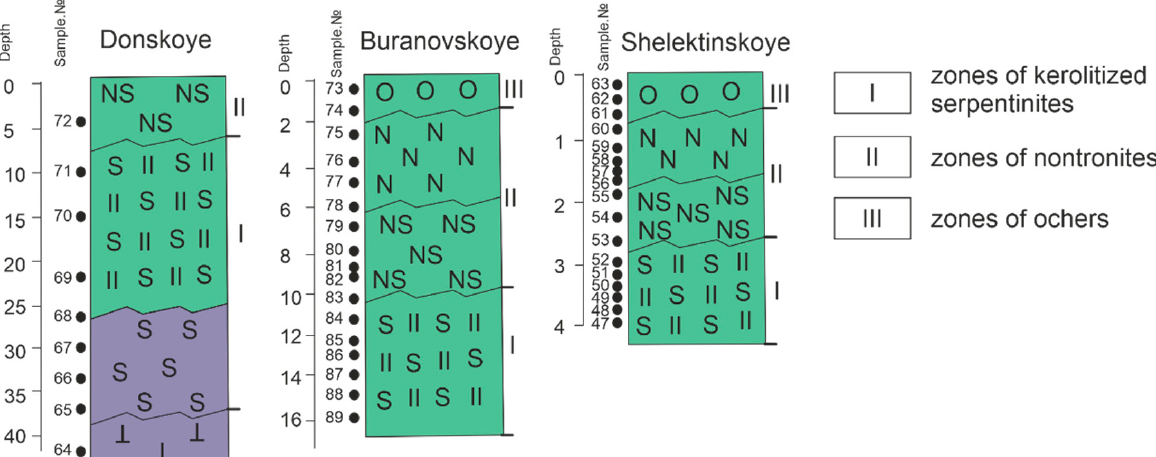
Figure 4. Zones of hypergenic transformation of the weathering rocks of ultramafic rocks Donskoye, Buranovskoye, and Shelektinskoye deposits. Note—symbols in Figure 3.